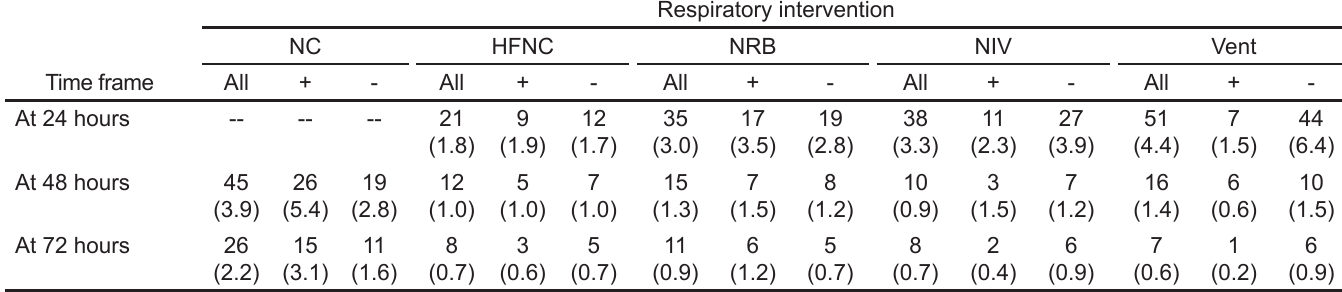
Table 4. Respiratory interventions.